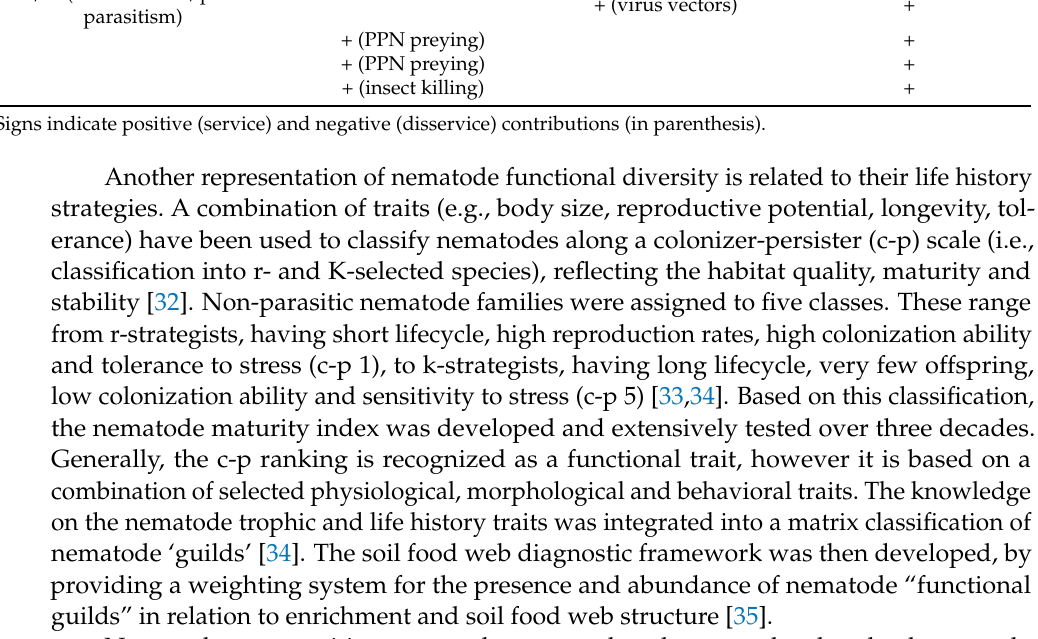
Table 1. A schematic list of nematode contributions to main soil functions and services provided by different trophic groups. Nematode Trophic Groups